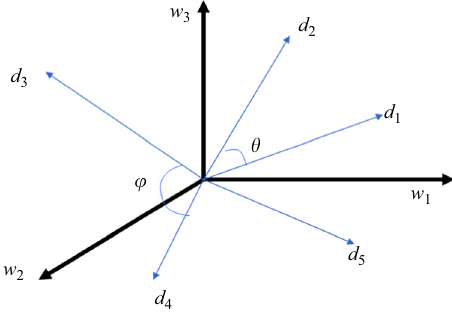
Figure 4. 3D semantic